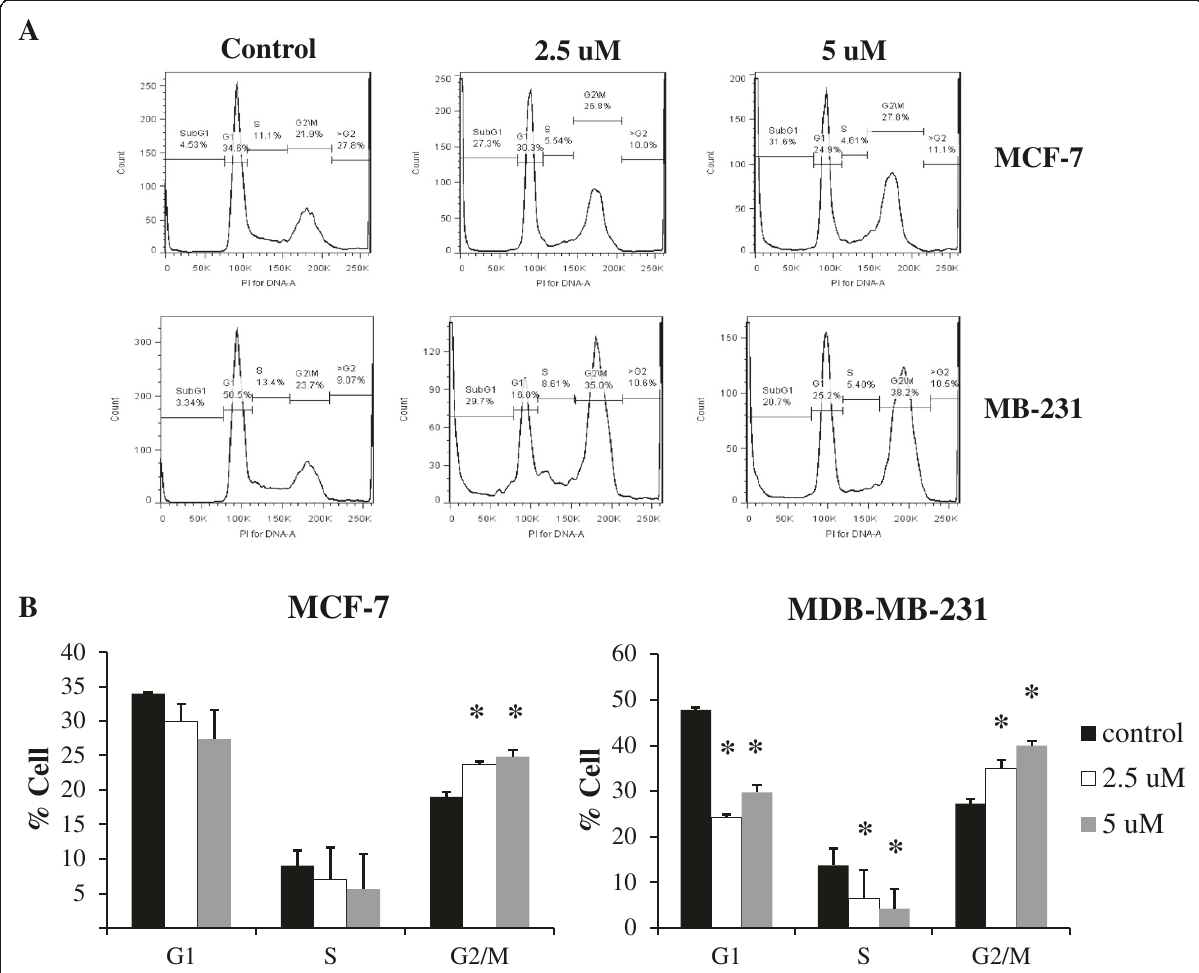
Figure 3 Effect of cucurbitacin B on cell-cycle distribution. MCF-7 and MDA-MB-231 were treated with 0, 2.5, and 5 μ M cucurbitacin B for 24 hr, and then stained with propidium iodide (PI) before subjected to flow cytometric analysis. A . The cell cycle/DNA content histograms represent the cell population at each cell cycle phase as determined by the level of DNA content in each cucurbitacin B treatmented group. Blockage at G 2 /M and apoptotic induction was observed. B . The values indicate percentage of cells in each phases of the cell cycle. *, p <0.05 (treated vs untreated